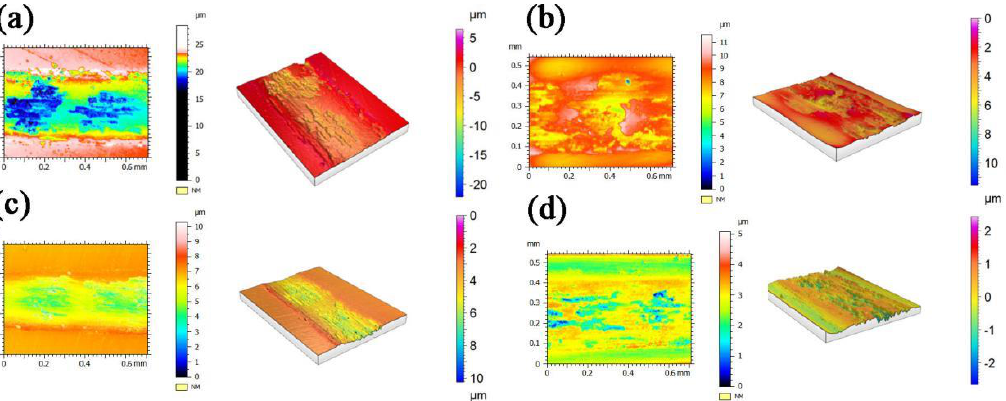
Figure 6. Three − dimensional surface morphology of the wear scratch: ( a ) 25 °C; ( b ) 500 °C; ( c ) 600 °C; ( d ) 700 °C.